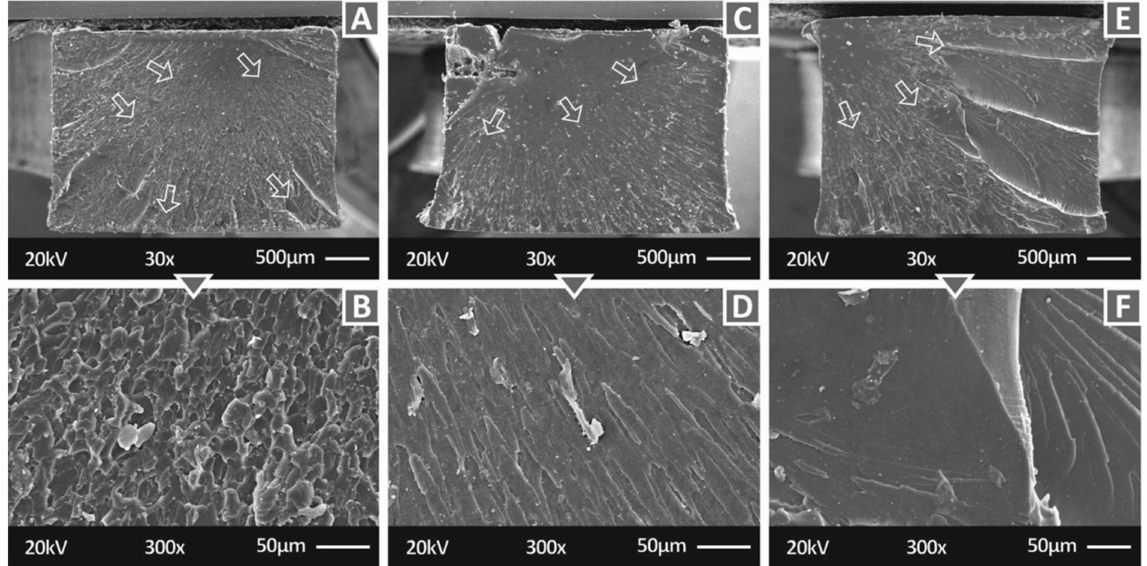
Figure 9. SEM images of the fracture surfaces of the specimens: ( A ) Biomed 1 wt.% Clear Antibacterial, 30 × , ( B ) Biomed Clear Antibacterial wt.%, 300 × , ( C ) Biomed Clear 1 wt.% Cu 2 O 30 × , ( D ) Biomed Clear 1 wt.% Cu 2 O 300 × , ( E ) Biomed Clear 1 wt.% Cu 30 × , and ( F ) Biomed Clear 1 wt.% Cu 300 ×